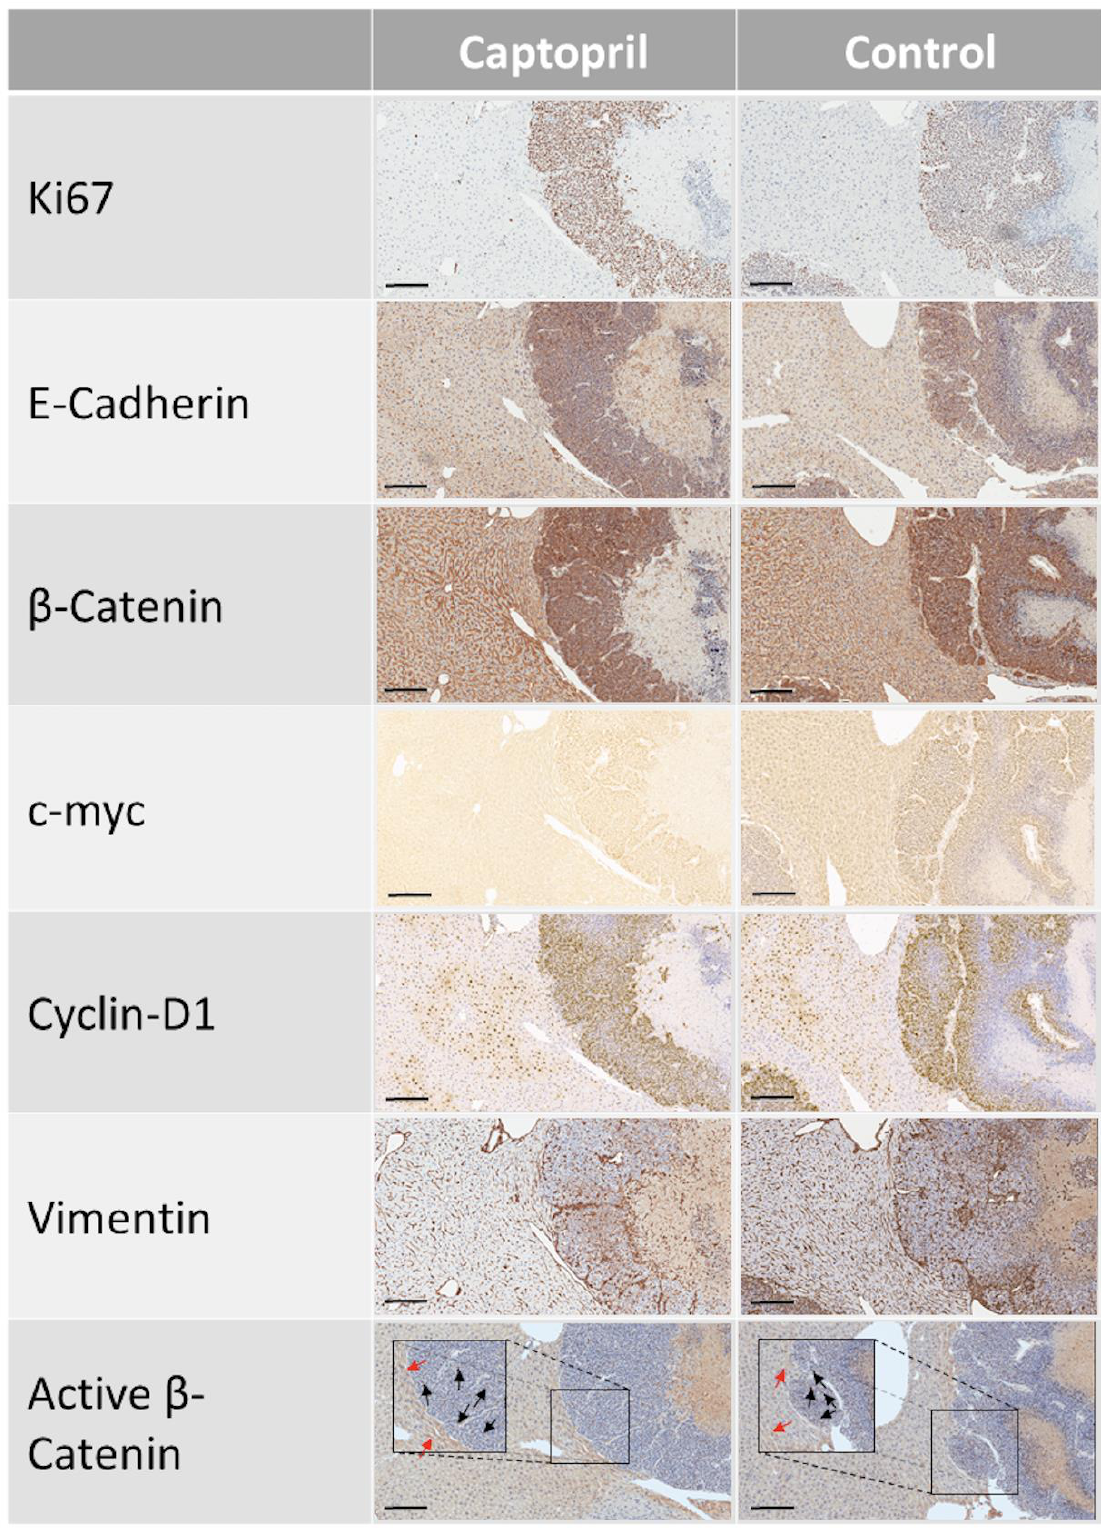
Figure 3. IHC on tissues from captopril treated and control mice. Fixed sections (control n = 9, captopril n = 10) were stained for Ki67, E-Cadherin, β -catenin, c-myc, cyclin D1, vimentin and active β -catenin. Scale bar, 200 µ